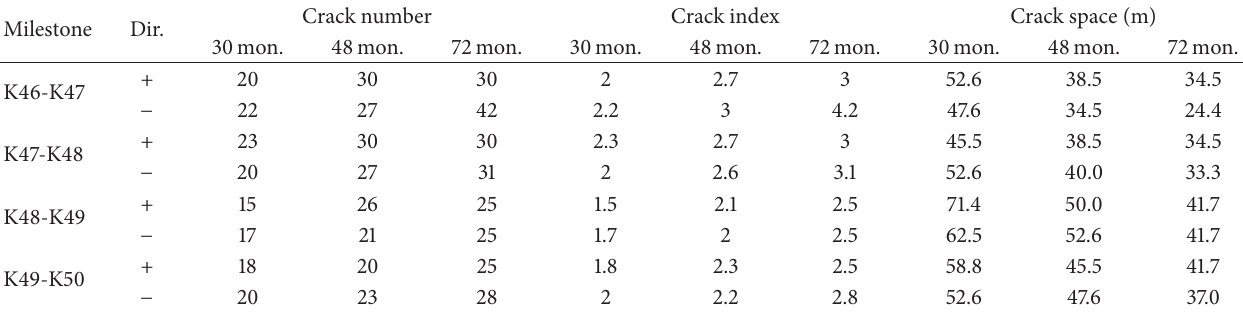
Table 9: Surveyed data of thermal cracking on Haxihuan Highway since traffic